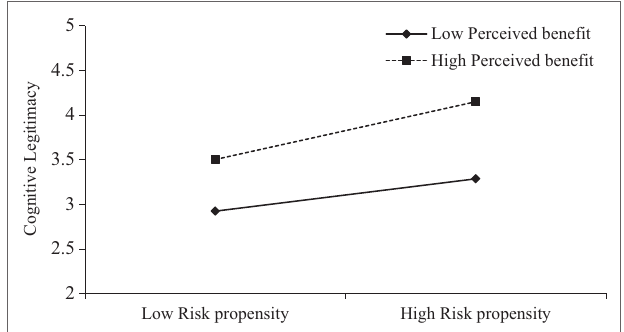
positively associated with perceived benefit ( r = 0.51, p <